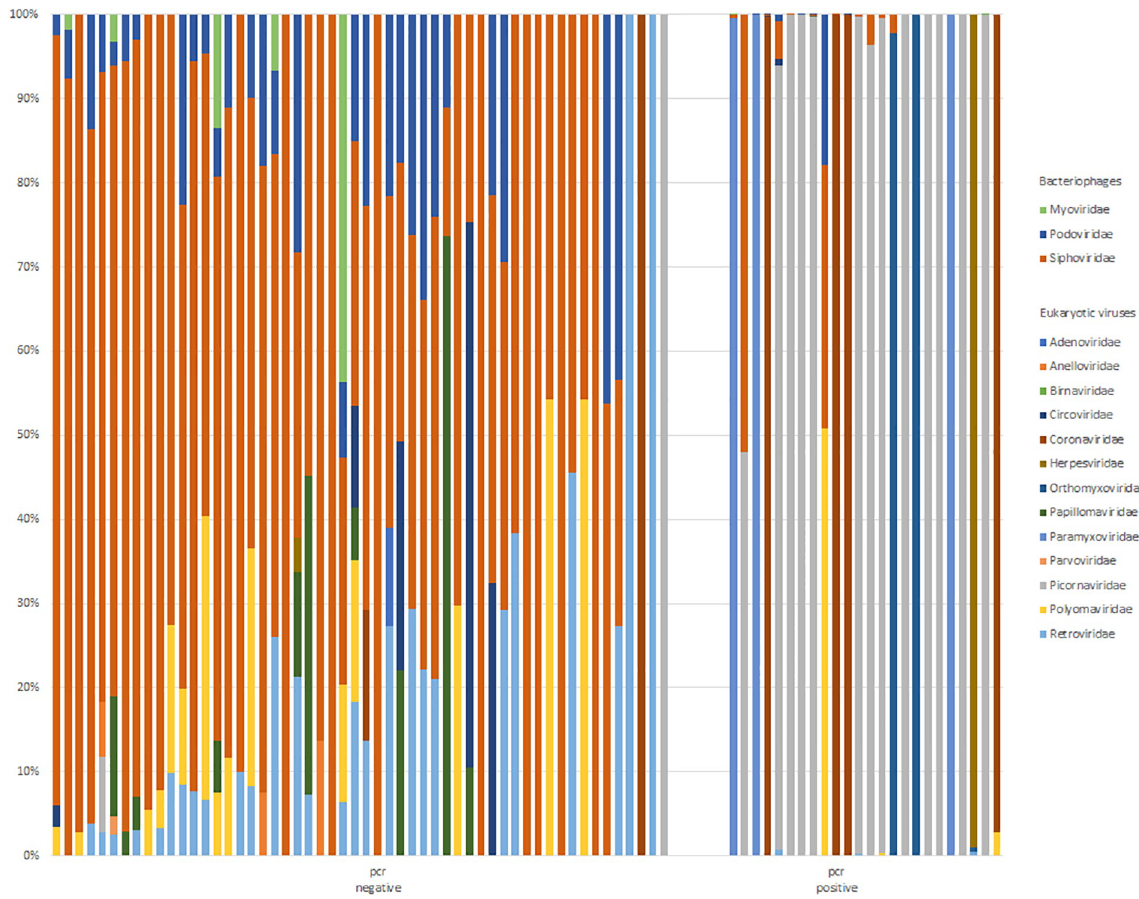
Fig 4. The respiratory virome: Proportion of normalized read counts of viral families per patient. Internal control reads (EAV and PhHV- 1) excluded, ten patients without viral reads excluded.